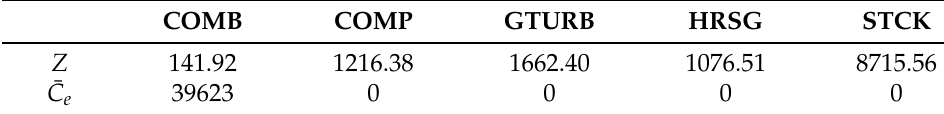
Table 10. Estimation of external resources costs (kW) for TGAS Plant.